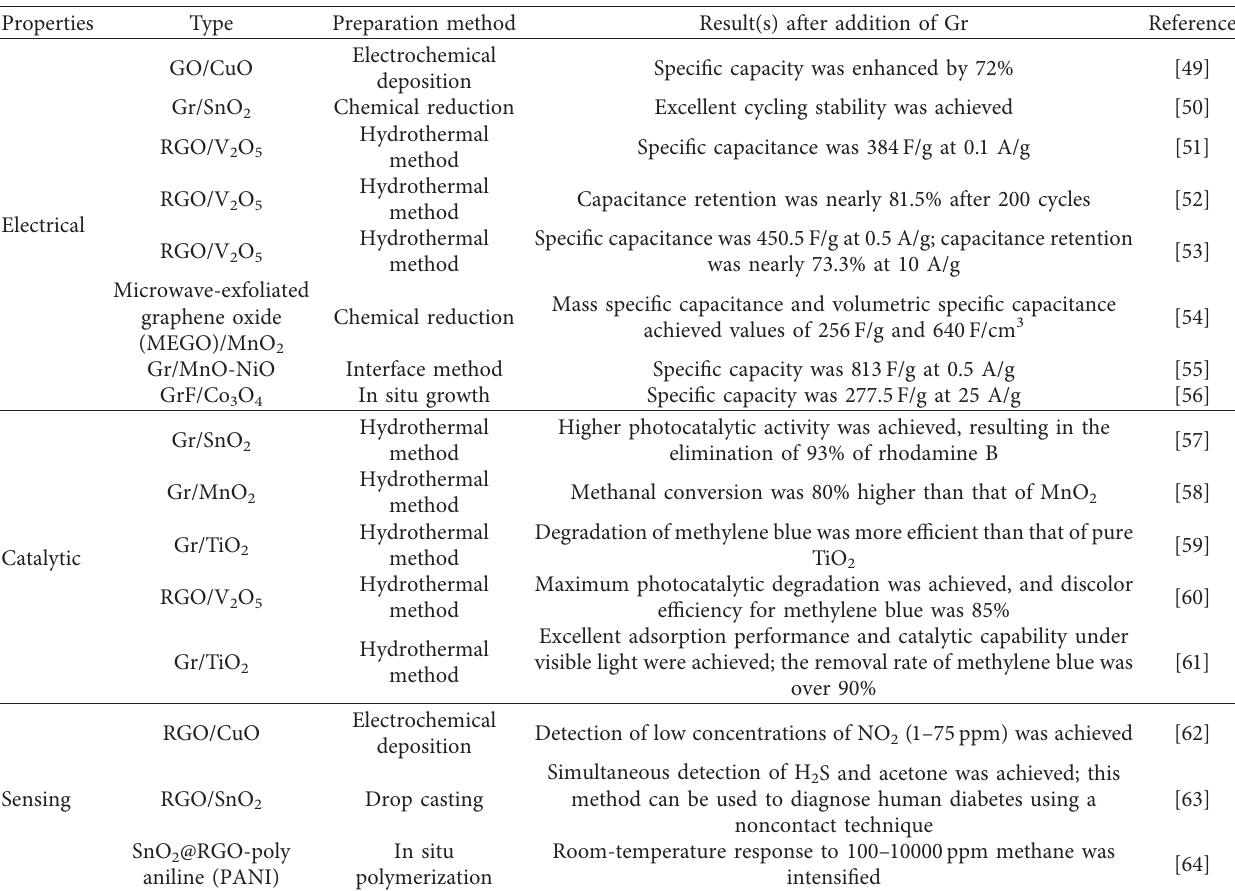
Table 3: Properties and preparation methods of graphene/metal oxide composite materials.